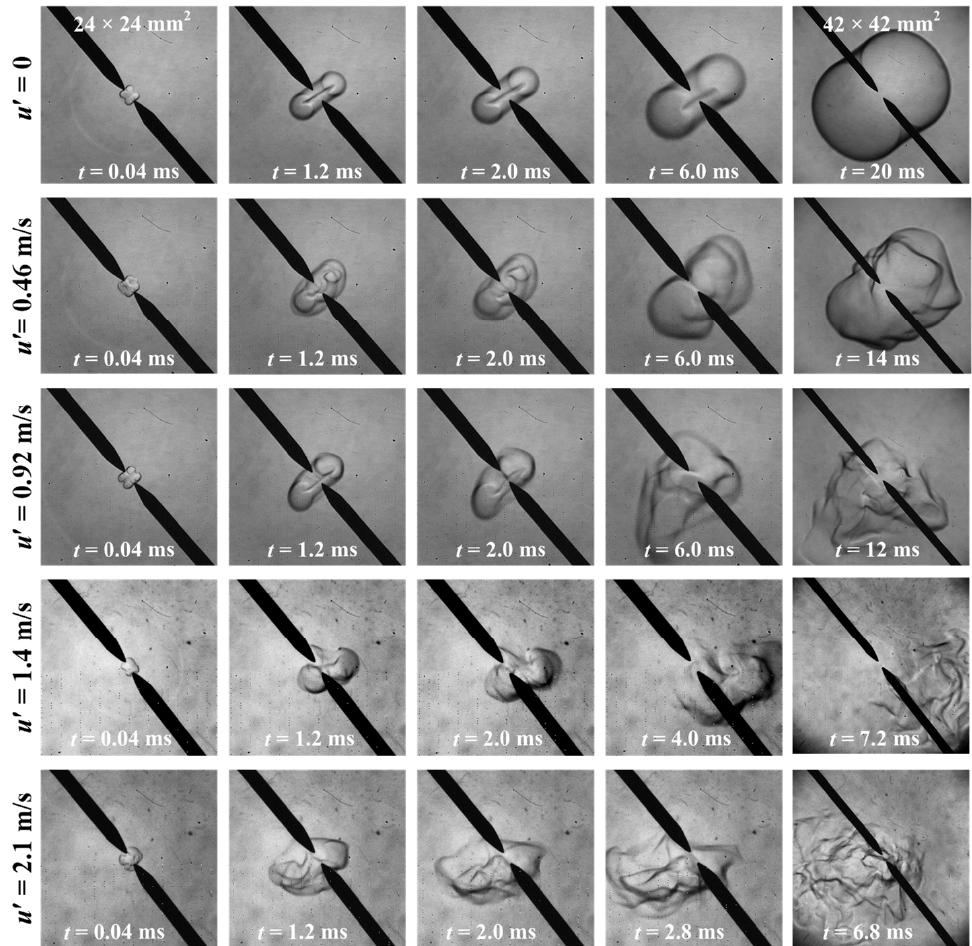
Figure 3. Time evolutions of high-speed schlieren images of the lean n-butane/air mixture at φ = 0.7 with Le ≈ 2.1 >> 1 at d gap = 2.0 mm in quiescence and at various turbulent conditions.